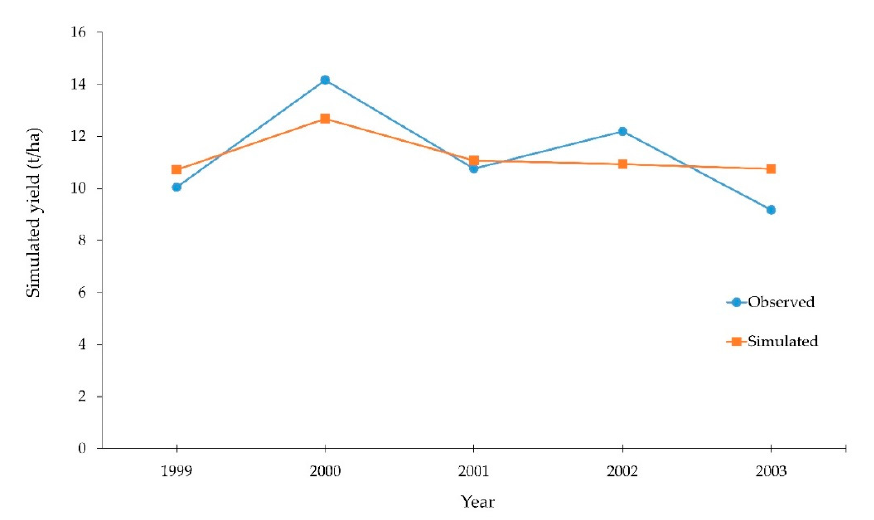
Figure 4. Comparison of observed yields in tonnes per hectare (t ha − 1 ) and simulated yields for the period with observed data after initial potential heat units (PHUs) calibration of the model.